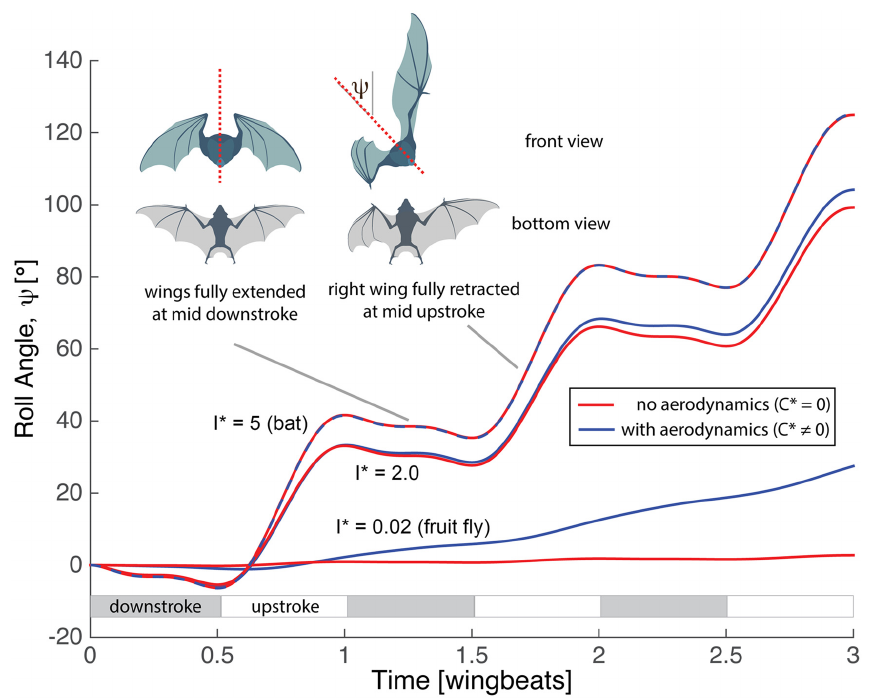
Fig 4. Minimal model of bat dynamics applied to body roll maneuver. Both wings are fully extended ( e r = e l = 1) at mid-dowstroke, while one wing is fully retracted ( e r = 0) at mid-upstroke. For morphological parameters matched to those of C . perspicillata ( I * = 5), simulations show that this asymmetric wing extension induces body roll and that aerodynamic forces do not influence the motion significantly. The response is insensitive to modest changes in the relative wing inertia ( I * = 2), although when the morphological parameters are matched to those of fruit flies ( I * = 0.02, C * = 0.05), aerodynamic forces dominate, while inertial forces have minimal effect on the body orientation. MATLAB code available in file minimal_simulation.zip from the Dryad Digital Repository, http://dx.doi.org/10.5061/dryad.21qs5